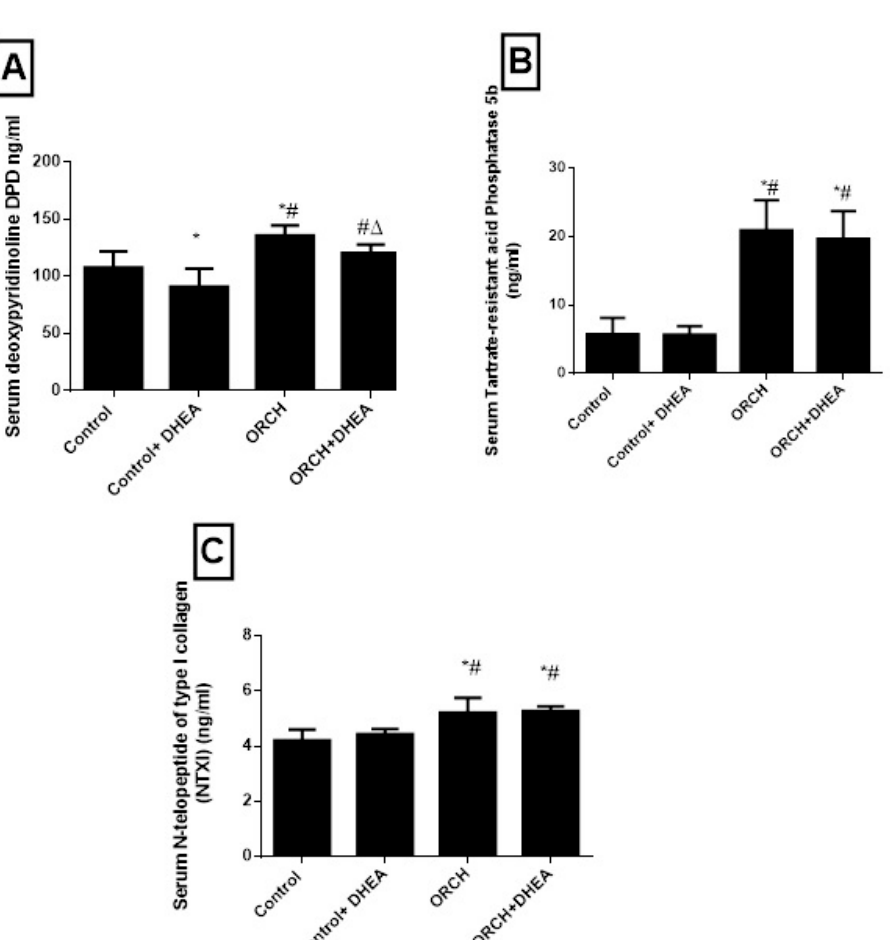
Figure 4. Effect of orchidectomy and DHEA treatment on serum level of on bone resorption markers ( A ) DPD, ( B ) TRAP-5b and ( C ) NTXI. Data were expressed as mean ± SD of 8 rats. *: p < 0.05 versus control, #: p < 0.05versuscontrol + DHEA, ∆ : p < 0.05versusORCH.ORCH:orchidectomy,Dpd: deoxypyridinoline;